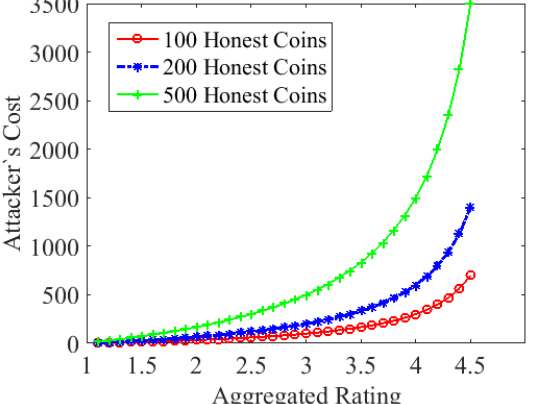
Figure 6. Cost for attacker to increase the aggregated score of 1 with 100, 200, and 500 honest